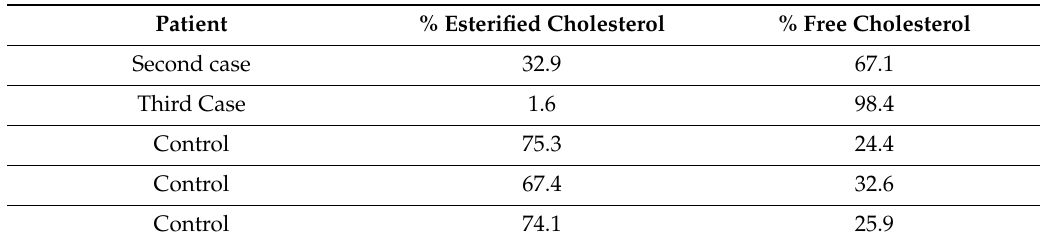
Table 3. Percentages of esterified and free cholesterol in the serum of 2 LCAT deficiency samples and 3